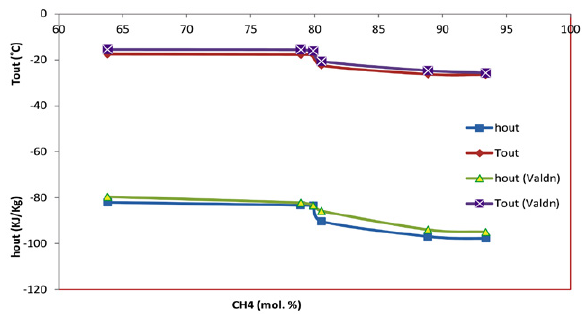
Fig. 2 . Effect of methane concentration variation on outlet enthalpy (kJ/kg) and outlet temperature (°C), Variable outlet